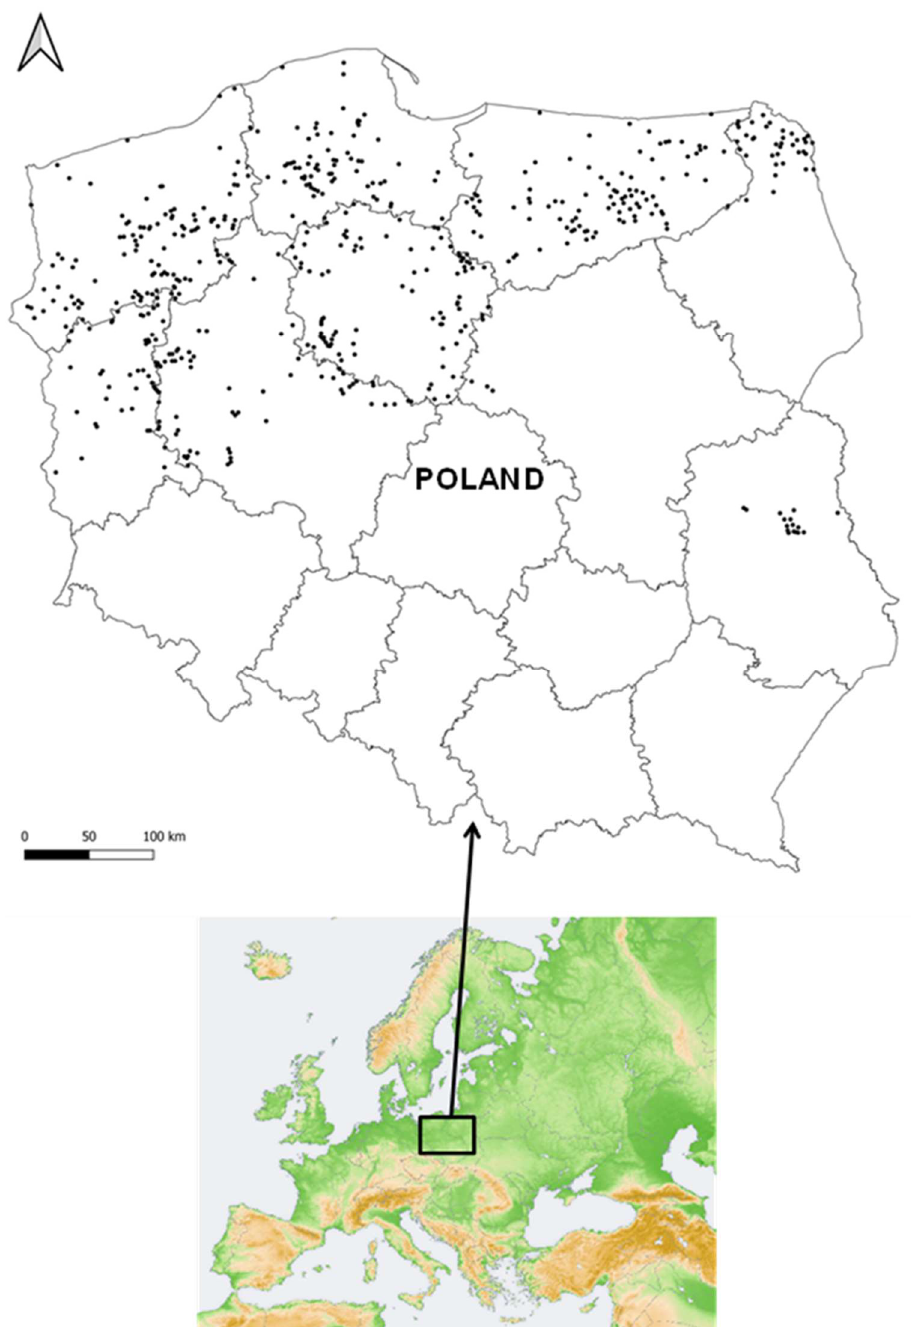
Figure 1. Map of Europe ( below ) and Poland ( above ) showing the geographical distribution of the 535 lakes sampled during the study.